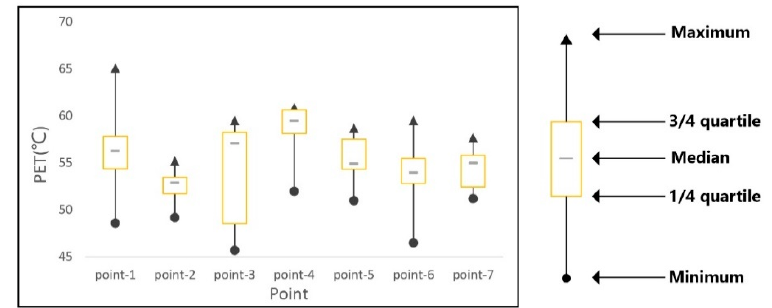
Figure 16. The PET of the selected points at 14:00.